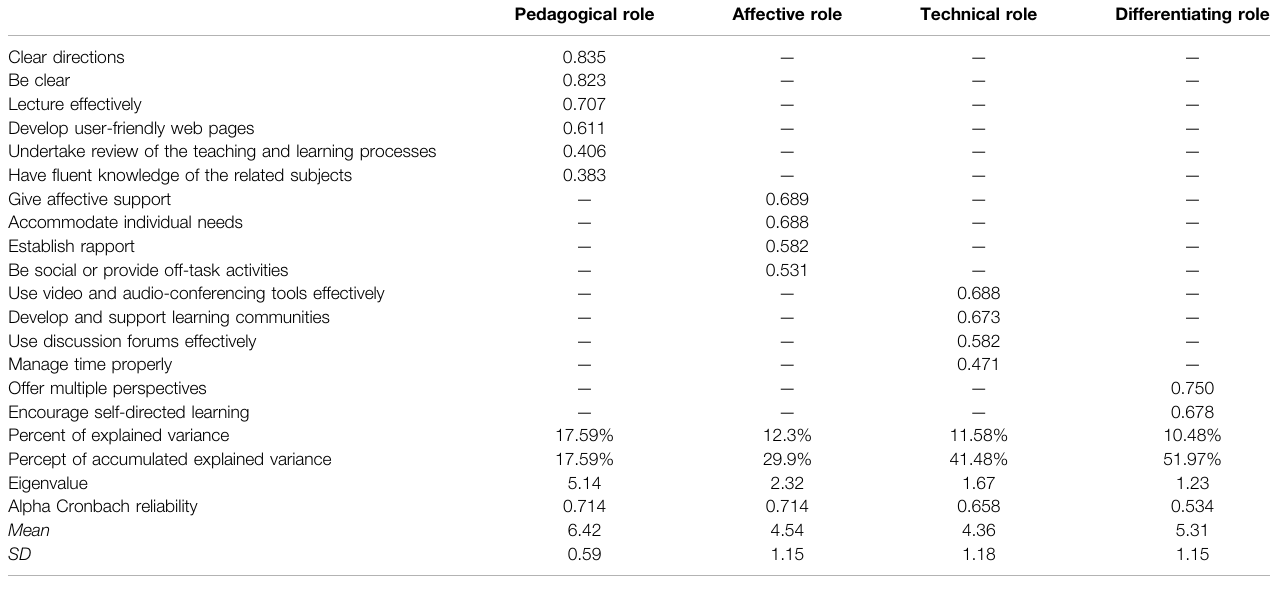
TABLE 3 | Students ’ statements, categorized by factor, and results of the Varimax factor analysis.